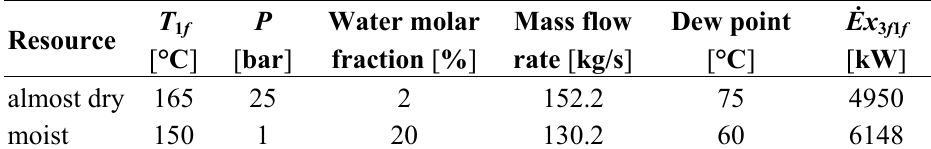
Table 1. Resource